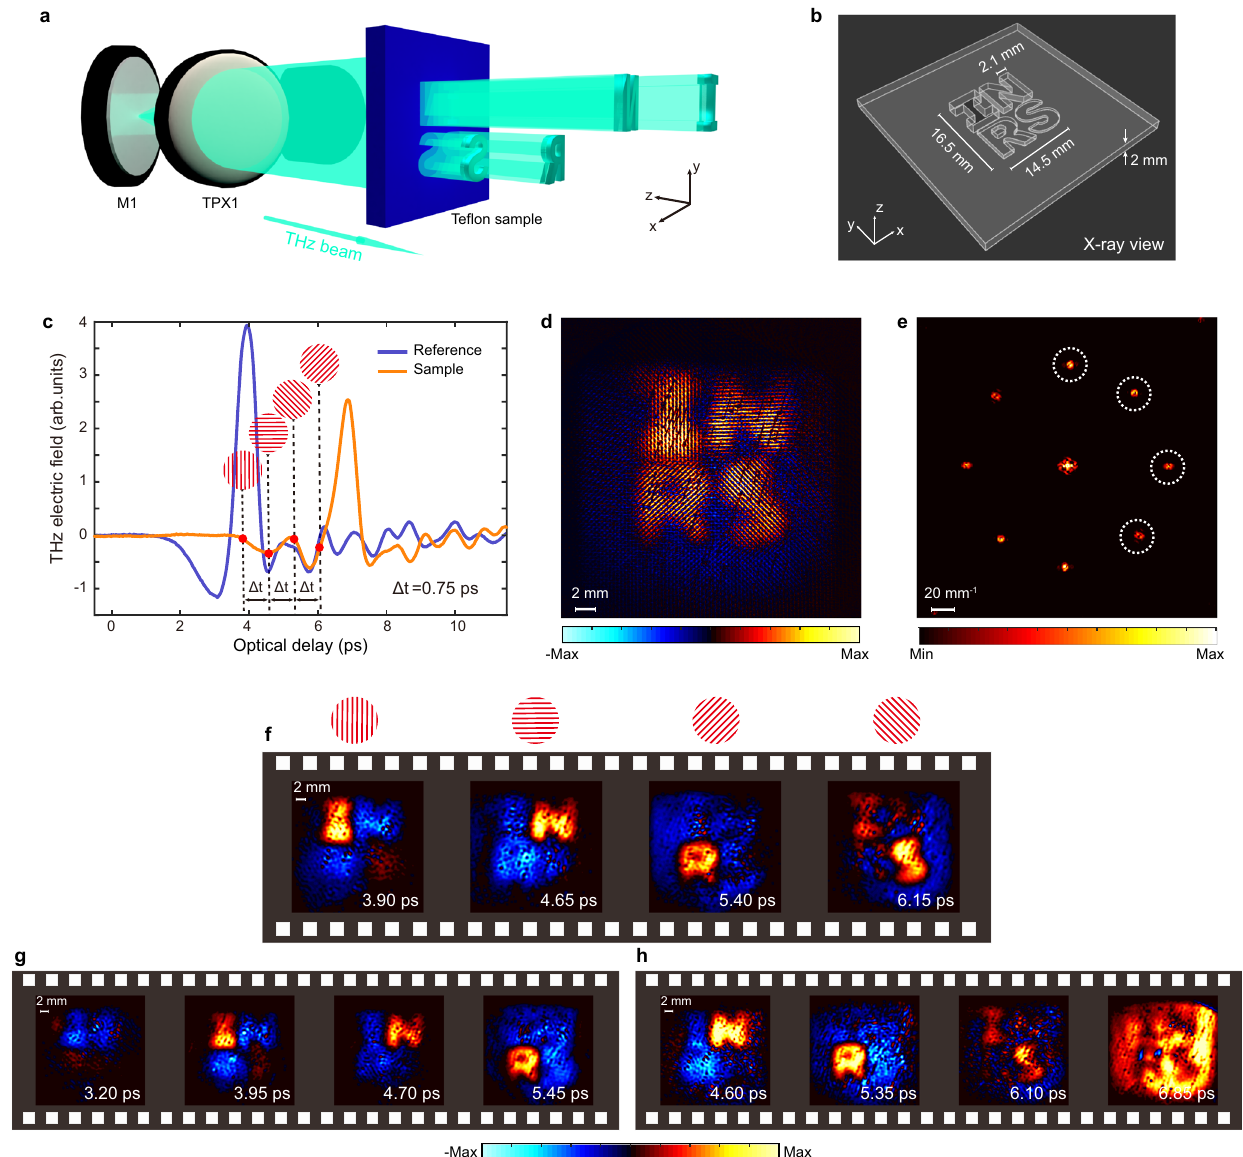
Fig. 3 | Ultrafast imaging of a THz pulse propagating through a patterned structure. a The dynamic scene consists of a collimated THz beam traveling througha Te fl on sheet (thickness: 2mm) with fourengraved letters( ‘ I ’ , ‘ N ’ , ‘ R ’ , and ‘ S ’ ). b Detailed geometries of the letters shown in an ‘ X-ray ’ view. The stroke width of the letters is ~2.1mm. The engraving depths ofthe four letters, ‘ I ’ , ‘ N ’ , ‘ R ’ , and ‘ S ’ , are 2mm, 1.5mm, 1.0mm, and 0.5mm, respectively. As a result, the letter ‘ I ’ is engraved throughout the sample along the depth direction. c THz waveforms acquired via the EOS technique with and without the sample. The arrival times of